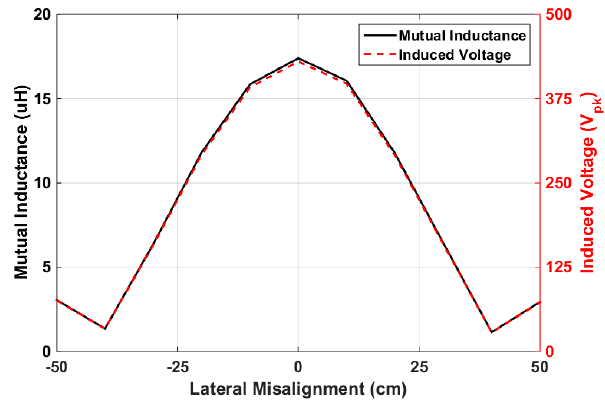
Figure 7. 3-D FEM simulation result showing a waveform comparison of the mutual inductance and the induced voltage on the load coil.